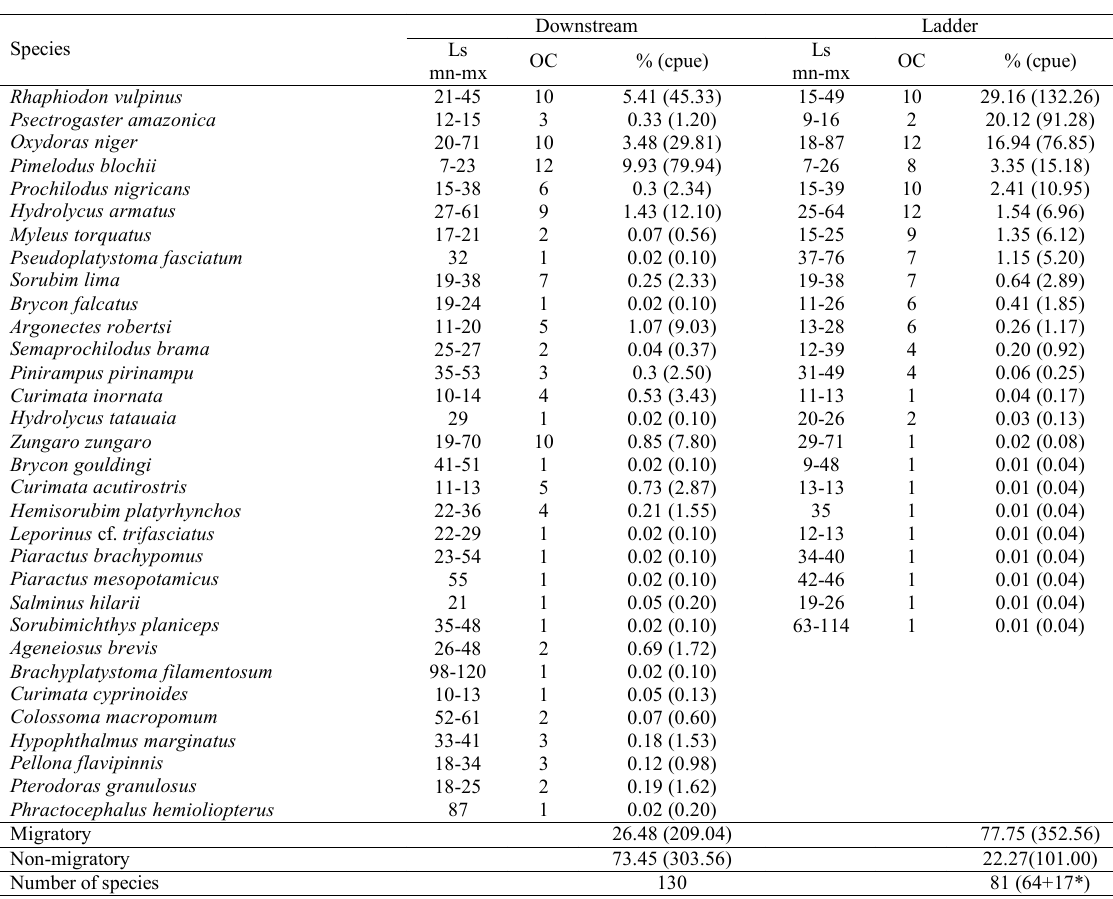
Table 1. Minimum (mn) and maximum (mx) standard length (Ls), occurrence (OC), percentage in the catches (%) and catch per unit effort (CPUE) of the migratory species recorded downstream from Lajeado Dam and in the fish ladder, from November, 2002 to October, 2003. Species organized in decreasing order of abundance in the ladder (CPUE: downstream = individuals per 1000 m 2 of gillnet nets set out for 24 hours; ladder = individuals per 100 casts; * = number of small-sized or rare species recorded in visual